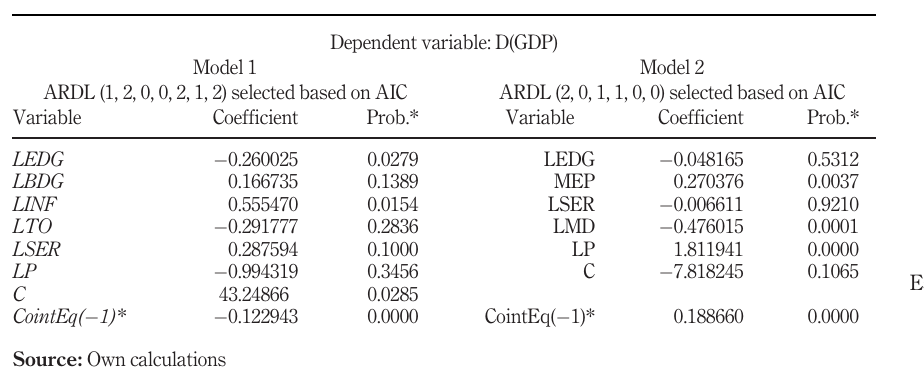
Table 7. Estimated